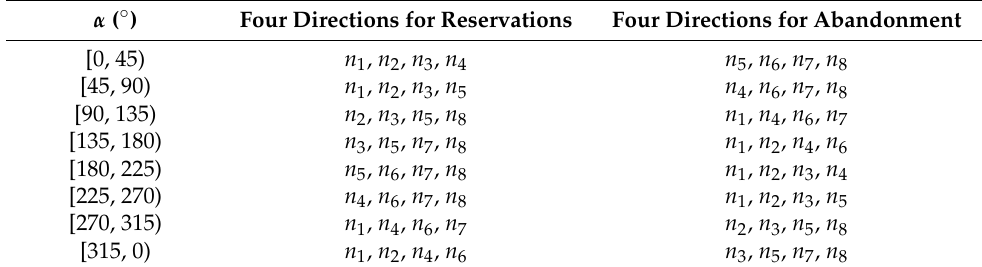
Table 2. Correspondence between α and search direction. α ( ◦ ) Four Directions for